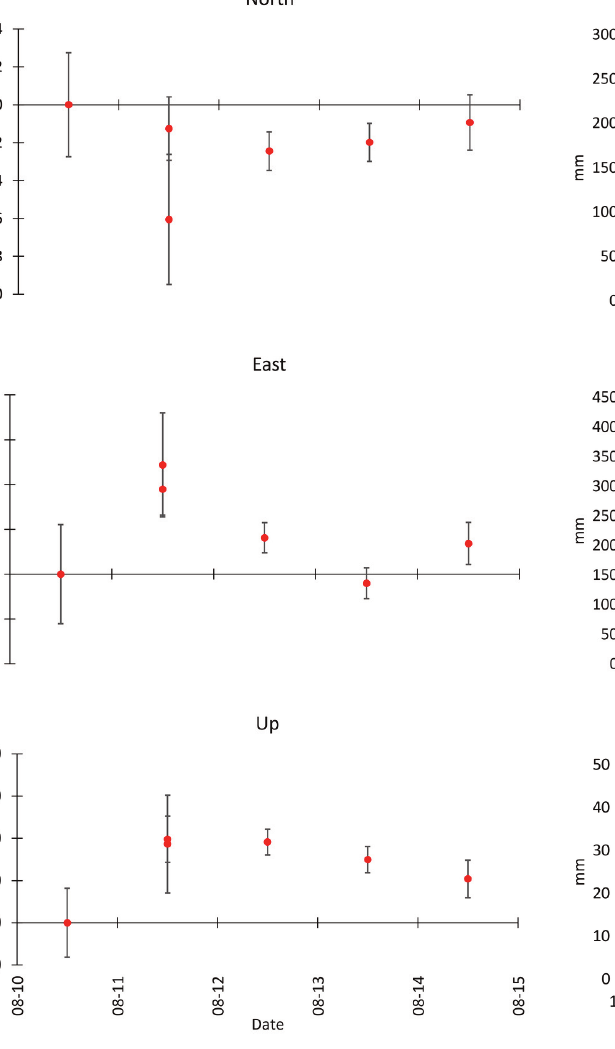
Fig. 2. The repeatability of the North, East and Up coordinates of the GRN point OJAKÜLA97 (Fig. 1) from different sessions of the GNSS campaign in 2017. Error bars denote standard deviations of the coordinates based on the PPP method.